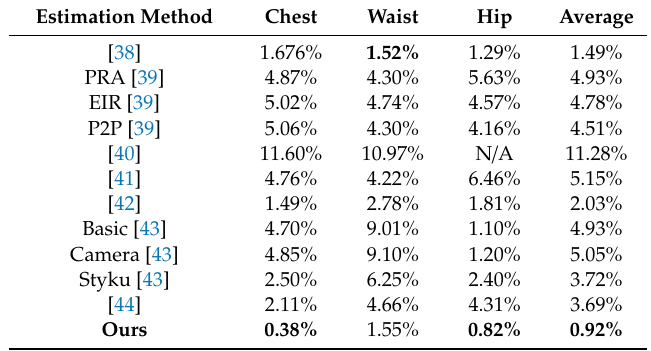
Table 8. Comparative results of body part perimeters according to the relative error (expressed in percentage). Lower values are better. The best results are in bold.